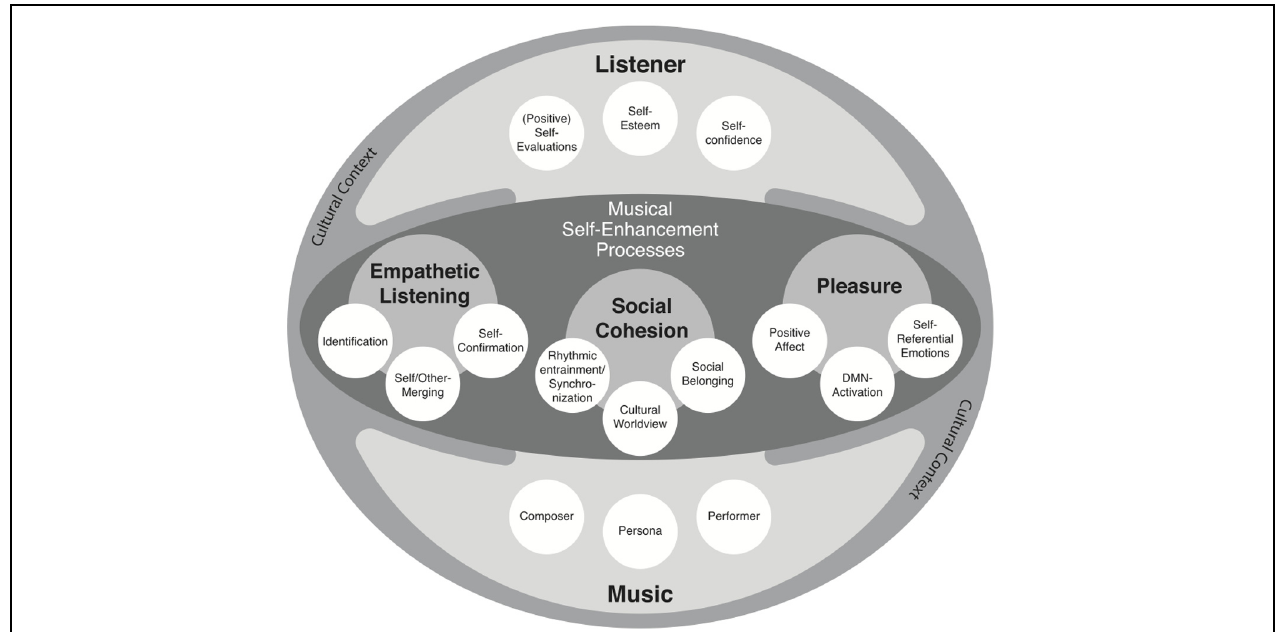
FIGURE 1 | Visualization of the framework of musical self-enhancement. The musical experience is embedded in a cultural context. The relationship between the music and the listener is realized in terms of different aspects of listening to music that may account as potential mechanisms of its self-enhancing function.